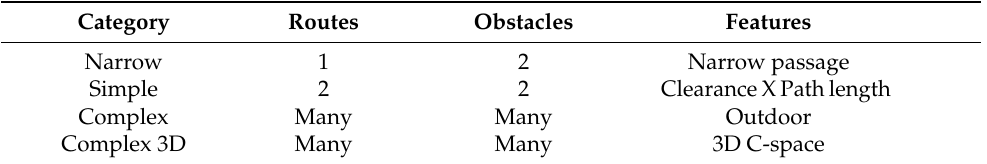
Table 1. Features of the maps used in the